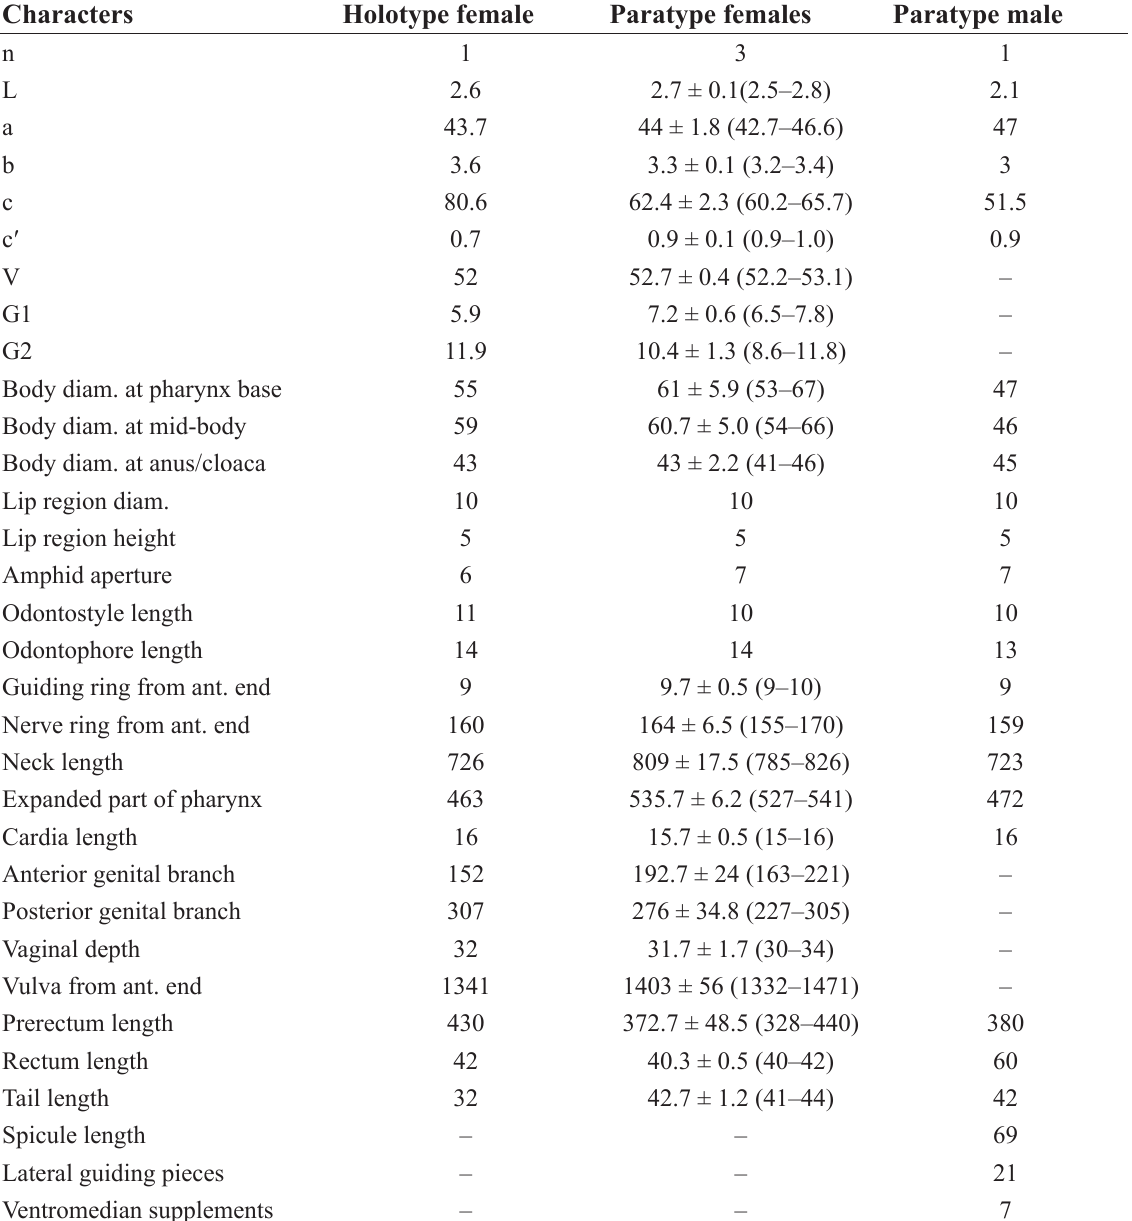
Table 8. Measurements of Axonchium paracingulatum sp. nov. All measurements in µm except L in mm, and in the form: mean ± s.d. (range) for